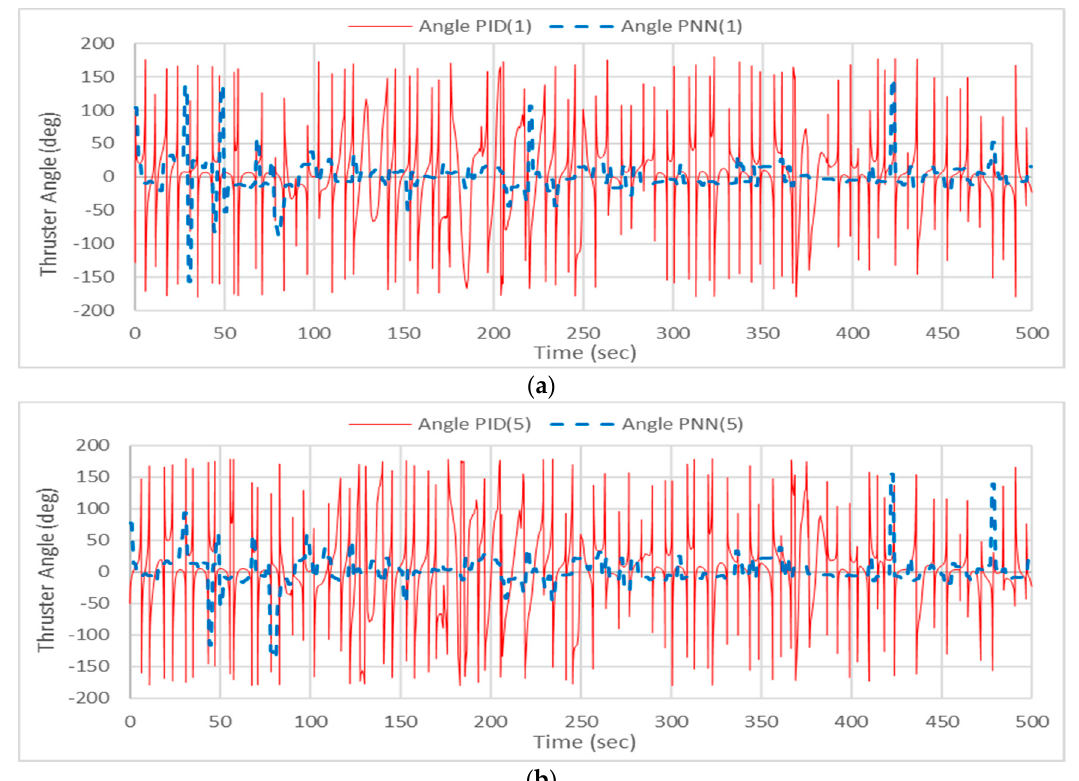
Figure 17. DP simulation with PID and PNN controls showing thruster force (Head sea): ( a ) Thruster 1; ( b ) Thruster 5.